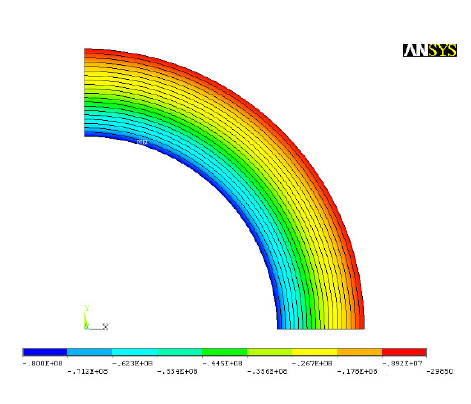
Figure 12. RadialstressobtainedfromANSYScodeinanFGMdisk ( ξ = 1 . 5 , η = 3) .